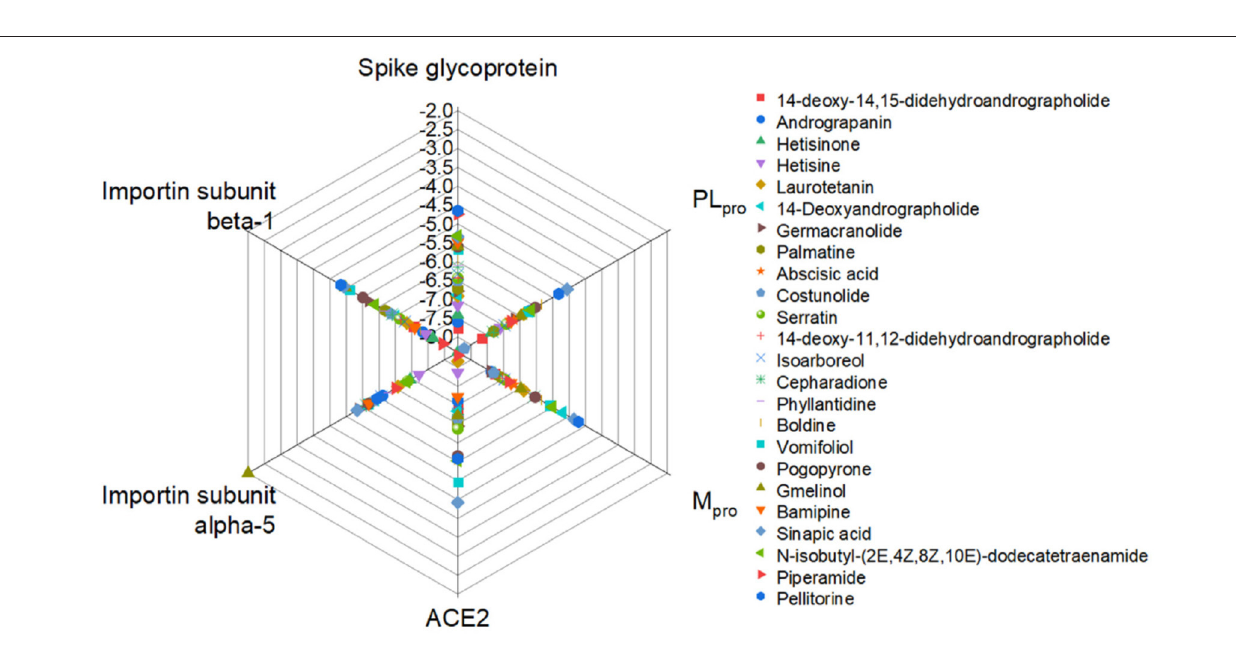
dependent RNA polymerase (84). Caffeic acid was also found virus